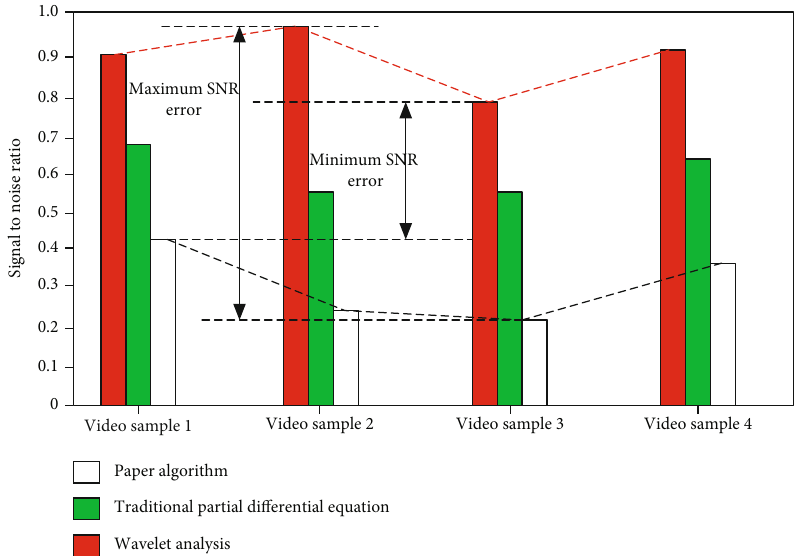
Figure 5: Experimental curve of signal-to-noise ratio of di ff erent algorithms under four groups of sample videos.